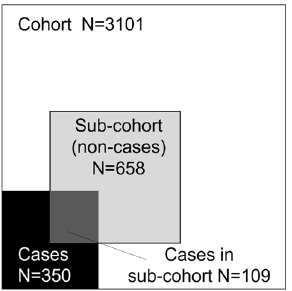
Figure 3. Sample selection for the CHAIN Nested Case-Cohort Study. Areas are proportional to the number of observations and excluding community participants are not